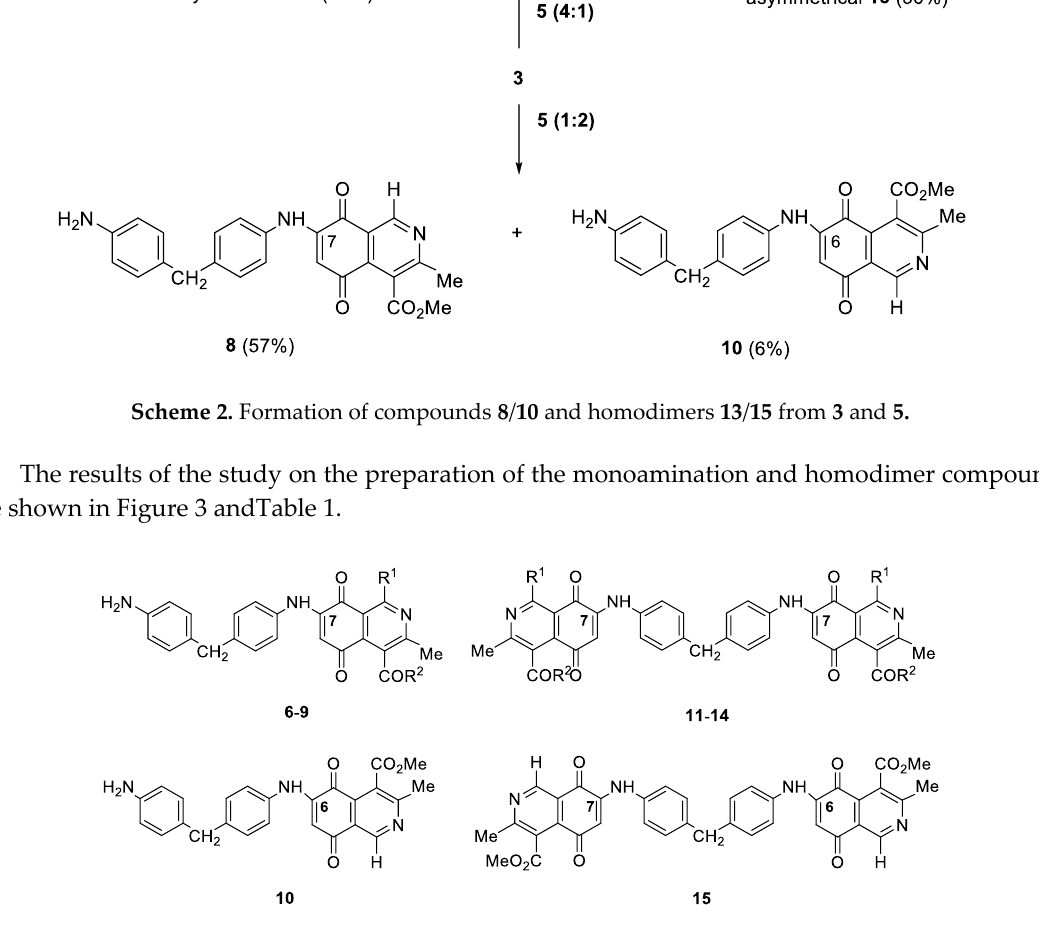
Figure 3. Structure of the monoamination and homodimer compounds 6–10 and 11–15 . Table 1. Yields of monoamination and homodimer compounds 6 – 10 and 11 – 15.